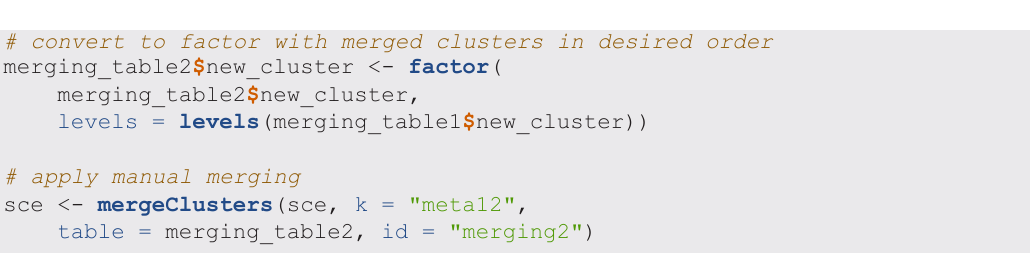
Comparison of automated and manual merging. The manual merging of 20 (or 12) clusters by an expert resulted in identification of 8 cell populations. To highlight the impact of manual merging versus algorithm-defined into 8 clusters. Out of interest, we can see which clusters are split by tabulating the cell labels.